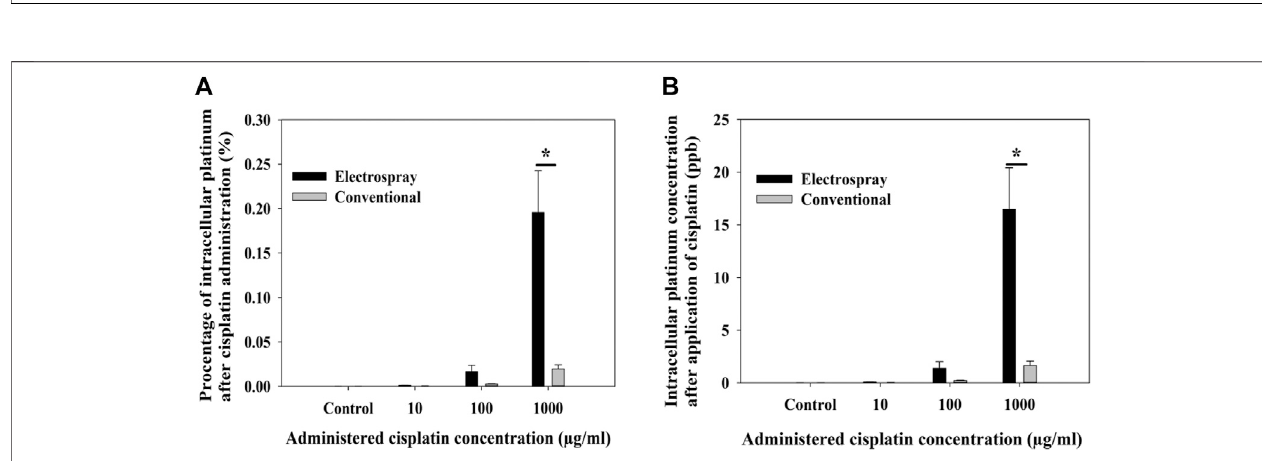
FIGURE 2 | Intracellular uptake of Cisplatin; percentage of delivered Cisplatin that entered the cells (A) and amount of intracellular Cisplatin (B) after electrospray mediated Cisplatin delivery in vitro . Data presented as mean ± SEM, p < 0.05*, p < 0.001 **, p < 0.0001 ***.